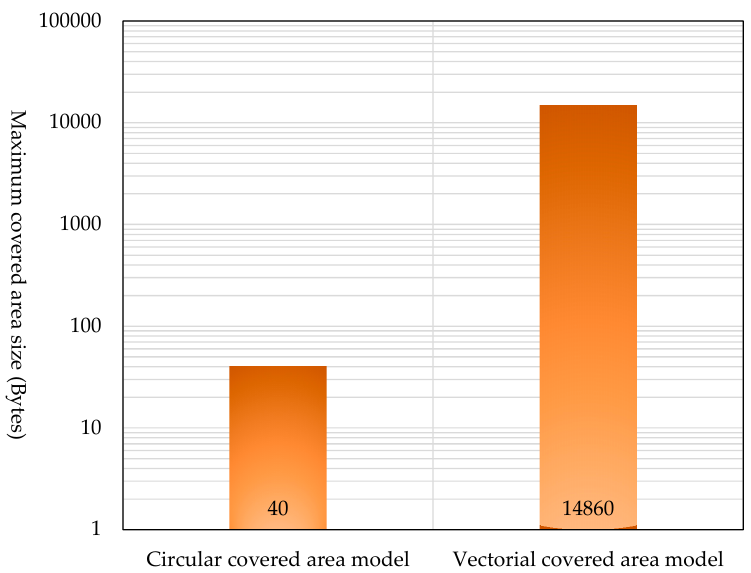
Figure 28. Comparison in terms of the maximum covered area size.